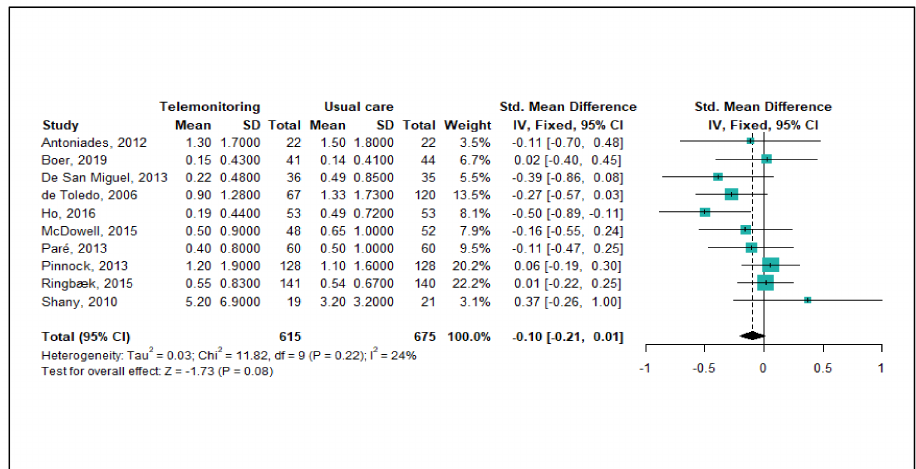
Figure 2. Forest plot of the effectiveness of telemonitoring for decreasing the number of hospitalisa- tions due to severe COPD